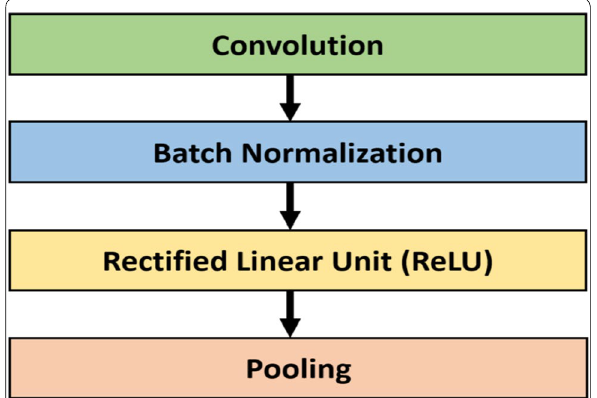
Fig. 2 Common building block of the proposed ensemble